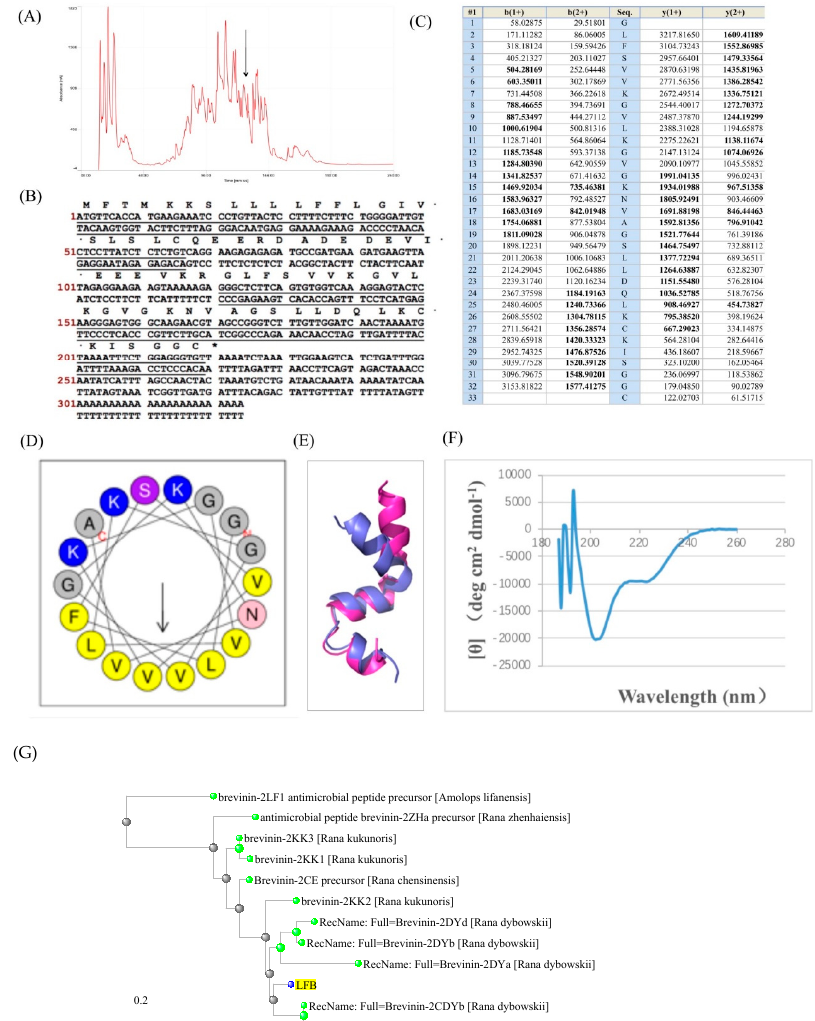
Figure 1. ( A ) Region of reverse phase high performance liquid chromatography (HPLC) chromatogram of Limnonectes fujianensis skin secretion indicating the elution position / retention time (arrow) of absorbance peak containing the peptide, Limnonectes fujianensis Brevinvin (LFB). ( B ) Nucleotide and translated open-reading frame amino acid sequence of the cloned cDNA encoding the biosynthetic precursor of LFB. The putative signal peptide is double-underlined and the mature LFB sequence is single-underlined. The stop codon was indicated with an asterisk. ( C ) Expected singly- and doubly-charged b -ion and y -ions arising from fragmentation of LFB as predicted using the MS-Product program available through Protein Prospector Online (http: // prospector.ucsf.edu / prospector / mshome. htm). Observed fragment ions are indicated in bold typeface and are underlined. ( D ) Domain architecture of pre-LFB. Residues 1–22 constitute the putative signal peptide. Residues 23–40 constitute the acidic spacer peptide region typified by classical -KR- (-Lys-Arg-) pro-peptide convertase processing sites (italicized and in bold typeface). The single copy of mature LFB (residues 41–73) is underlined and in bold typeface. ( E ) Predicted protein structure of LFB. ( F ) Circular dichroism (CD) spectra of LFB. The spectra have subtracted bu ff er. ( G ) The distance tree of LFB using NCBI